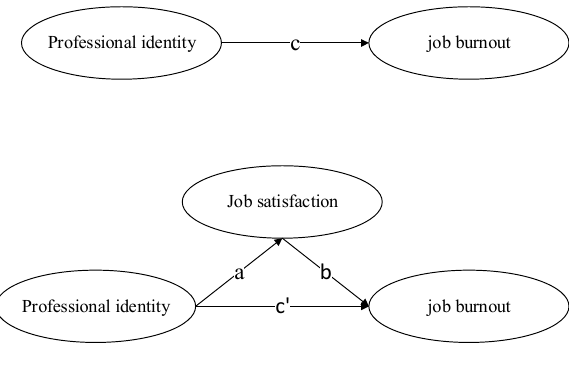
Figure 1. Hypothesis model.